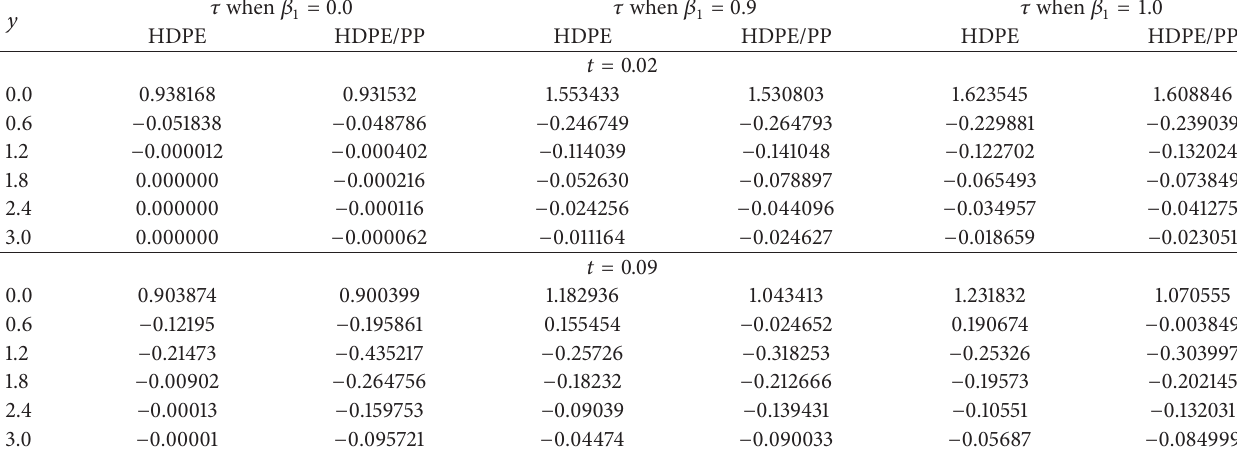
Table 7: Stress values of HDPE and HDPE/PP fluids for different 𝛽 1 when 𝛼 1 = 𝛼 2 = 𝛽 2 = 1 ; 𝑡 = 0.02, 0.09